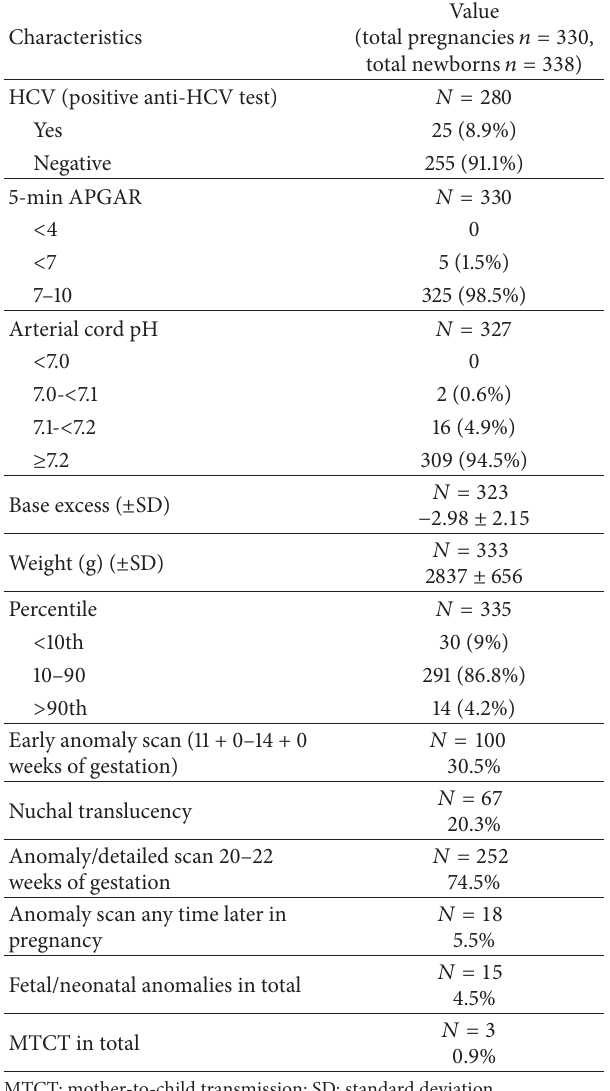
Table 1: Maternal and neonatal